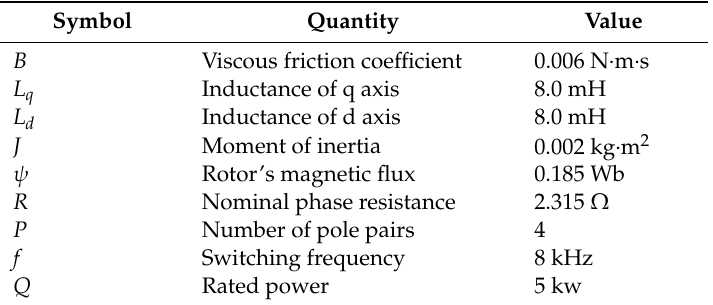
Table 2. Parameters of the permanent magnet in-wheel motor (PMIWM).